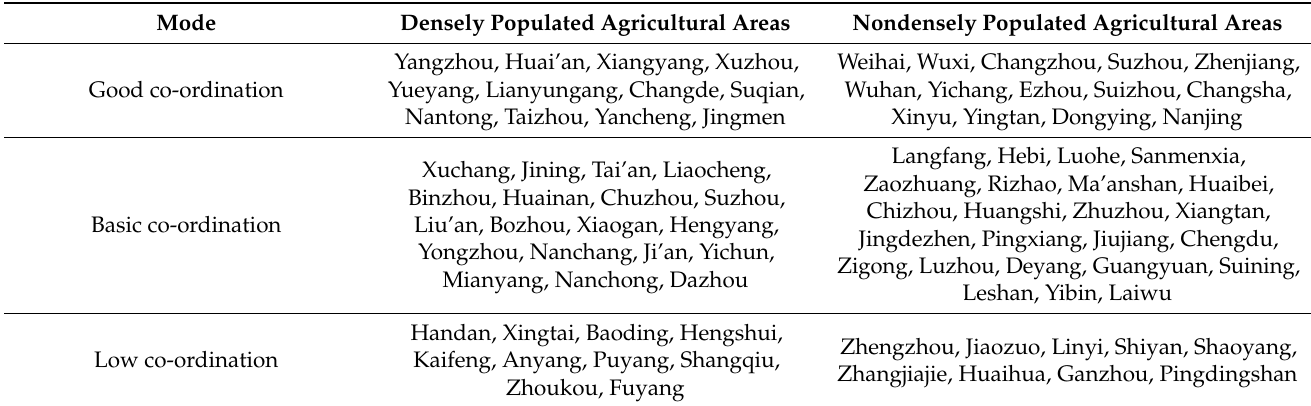
Table 7. Co-ordinated development modes remained unchanged during